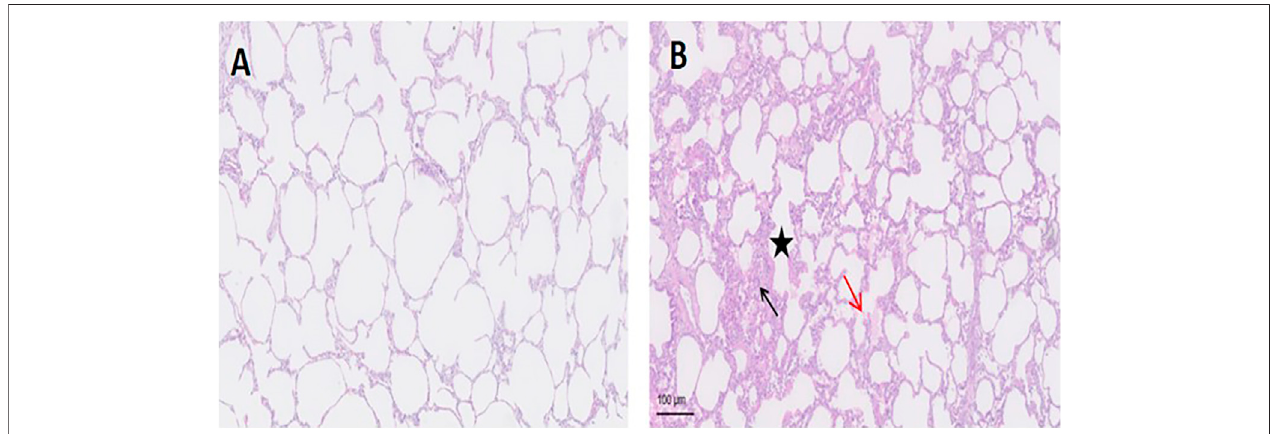
FIGURE 3 | Lung histology of the representative lung histological specimen of HE staining from the LTV and APRV groups is shown. (A) APRV; (B) LTV. Black arrow: thein fi ltrationofneutrophilsinalveoli;redarrow: proteinfragmentsinalveoli;star:thickenedalveolar wall.APRV,airwaypressurereleaseventilation;LTV,lowtidal volume ventilation; HE, hematoxylin – eosin staining.